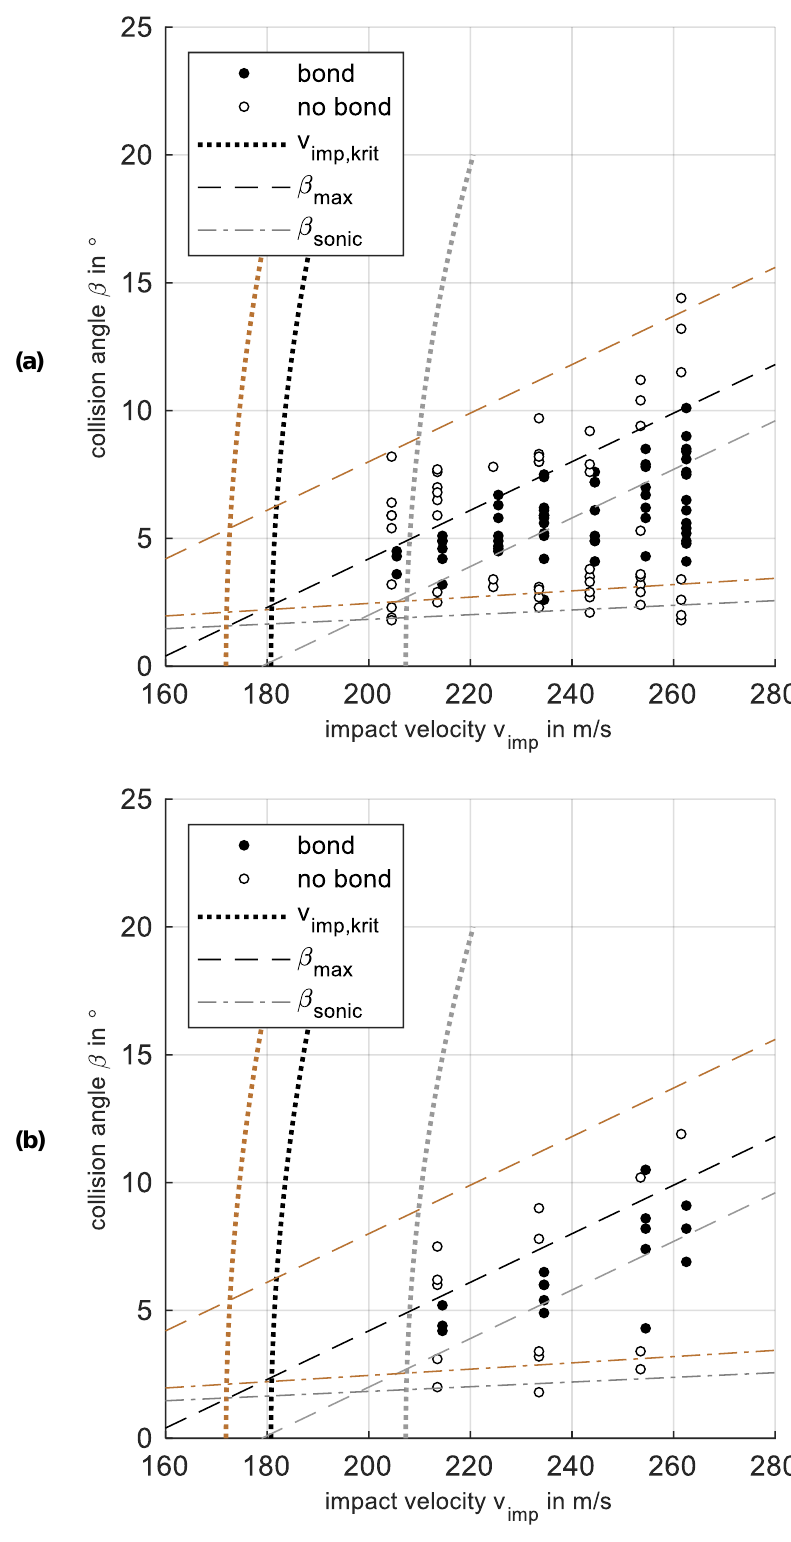
Figure 3. The welding windows of Al as flyer and Cu as target ( a ) and of Cu as flyer and Al as target ( b ). To improve the visibility of the data points, welded experiments are plotted with +0.5ms − 1 , non-welded with − 0.5ms − 1 . The determined boundaries of the welding windows of Al–Al (gray) and Cu–Cu (orange) were added, as can be seen in Figure 2. The upper collision angle boundary β max of Al–Cu (black) was linear approximated as those of the similar material combinations. The minimal impact velocity v imp,krit of Al–Cu (black) was calculated with Equation (2) and the corresponding mean values of ultimate tensile strength and density of both materials, as can be seen in Section